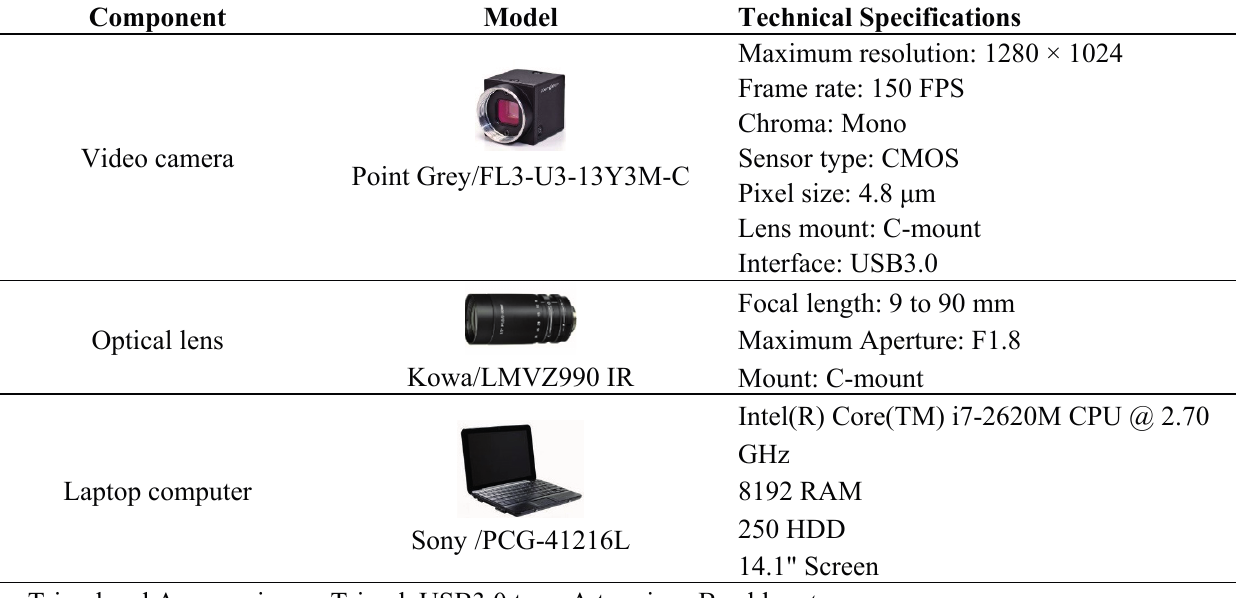
Table 1. Technical specifications of the proposed vision sensor